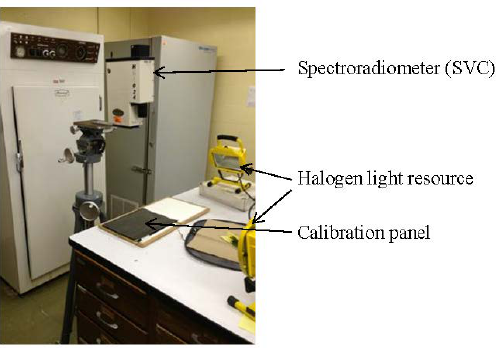
Figure 2. Laboratory set-up including spectroradiometer and halogen light sources.